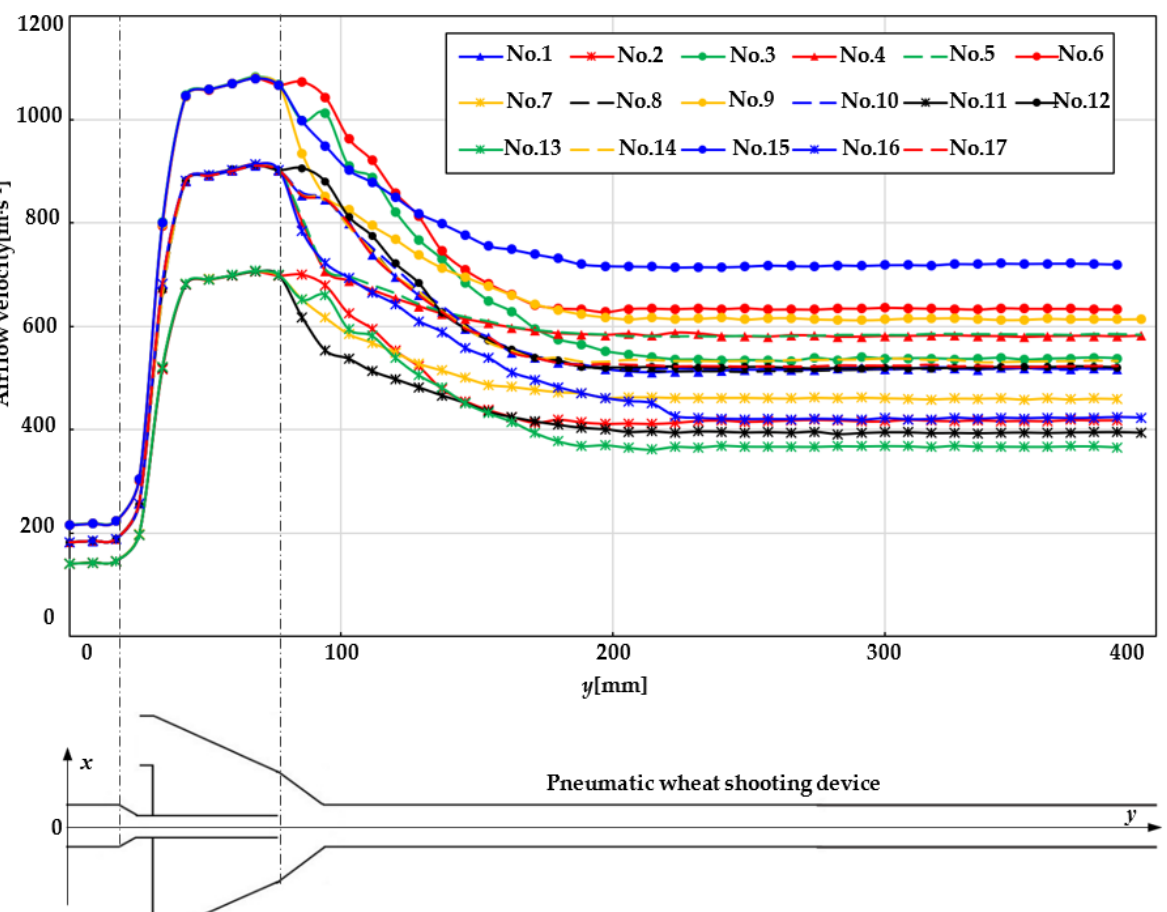
Figure 3. Velocity curve of central airflow field.